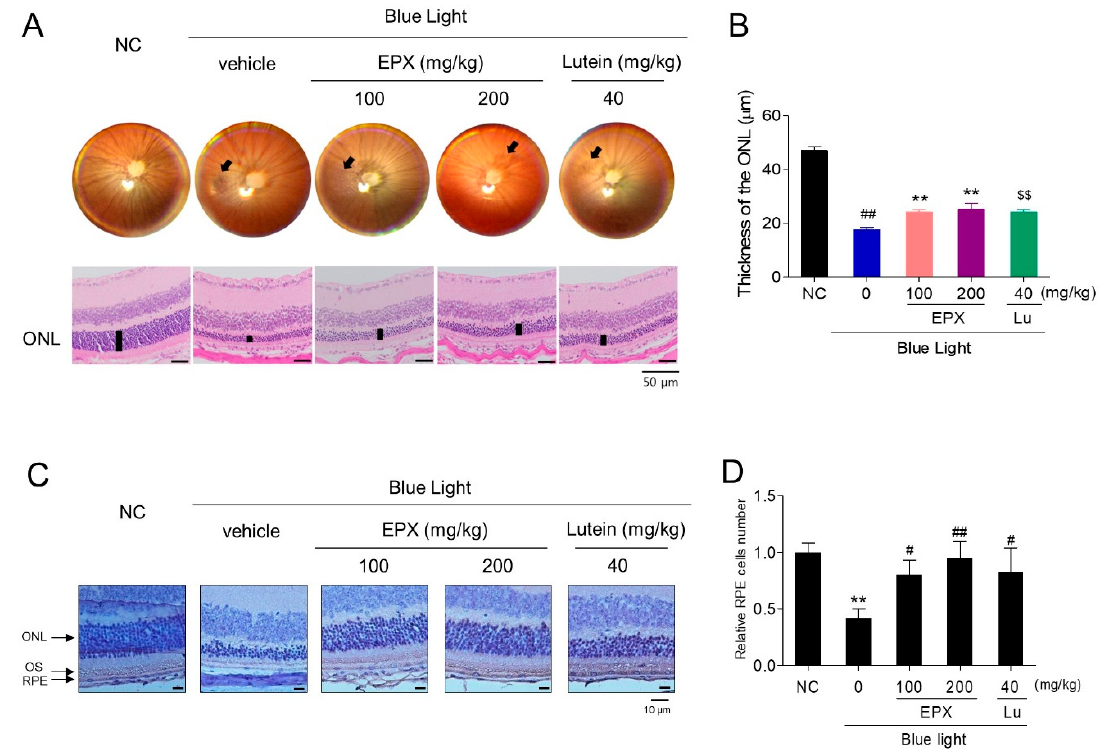
Figure 8. Protective effects of oral administration of EPX against retinal damage in a blue light-induced mouse model. ( A ) Histological analysis for the evaluation of morphological changes. ( B ) Measurement of the outer nuclear layer (ONL) thickness. Scale bar = 50 μ m. ONL—outer nuclear layer; Lu—lutein. The results are presented as the mean ± S.D. ( n = 8). ##— p < 0.01 vs. NC group (Student’s t -test), $$ —p < 0.01 vs. BL group (Student’s t -test), ** —p < 0.01 vs. BL group (One-way ANOVA). ( C , D ) Measurement of RPE cell number in a blue light-induced retinal damage model in mouse. ONL—outer nuclear layer, OS—outer segment, RPE—retinal pigment epithelium. The results are presented as the mean ± S.D. **— p < 0.01 vs NC group (Student’s t -test), #— p < 0.05, ##— p < 0.01 vs BL group (One-way ANOVA).